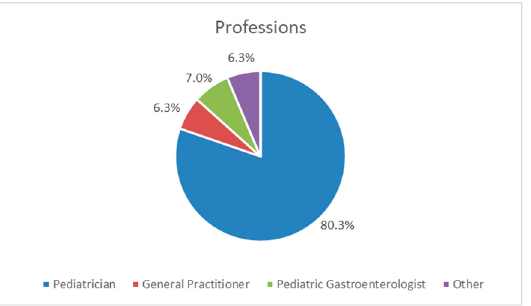
Figure 2. The professions of the respondents as a percentage of the total number of respondents.